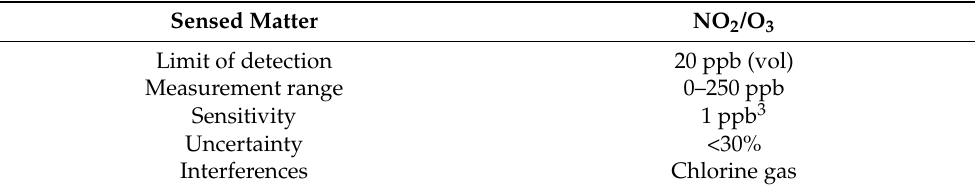
Table 2. Technical specifications of the Cairsens© NO 2 /O 3 sensor